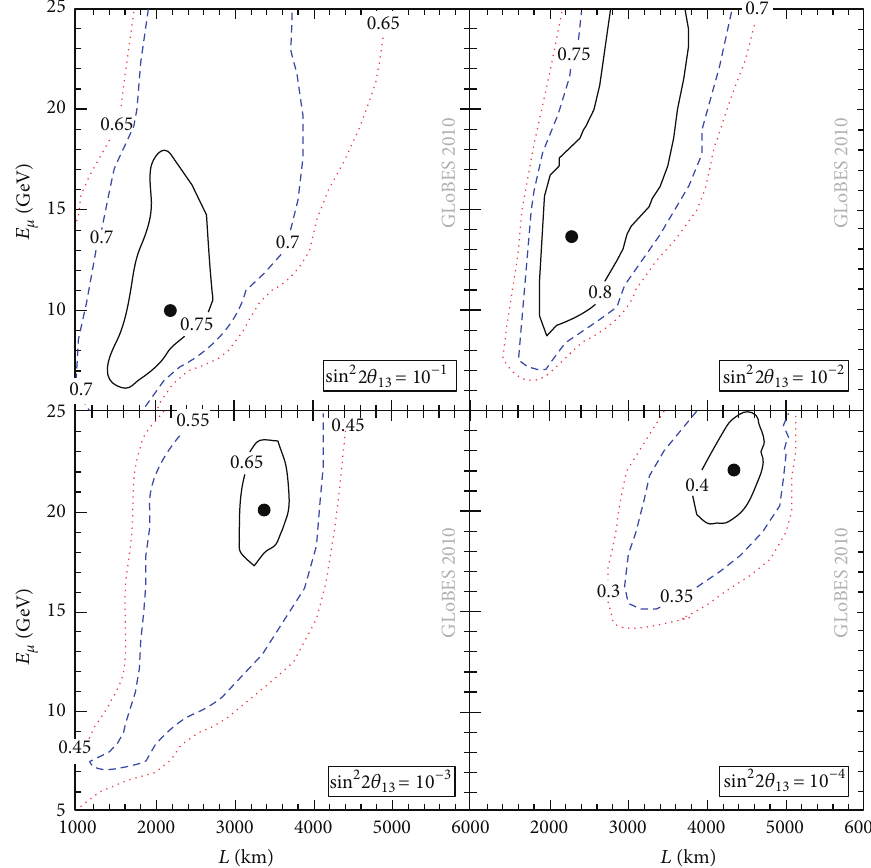
Figure 17: Fraction of the values of 𝛿 for which there is sensitivity to CP violation at 3𝜎 as a function of 𝐿 and muon energy. A single baseline Neutrino Factory is used with a 50 kton MIND detector. The optimal performance is marked by a dot. Figure is taken from [147]. Table 2: Summary of the “nominal” luminosities for the current generation of reactor and beam experiments. See [45] for details.